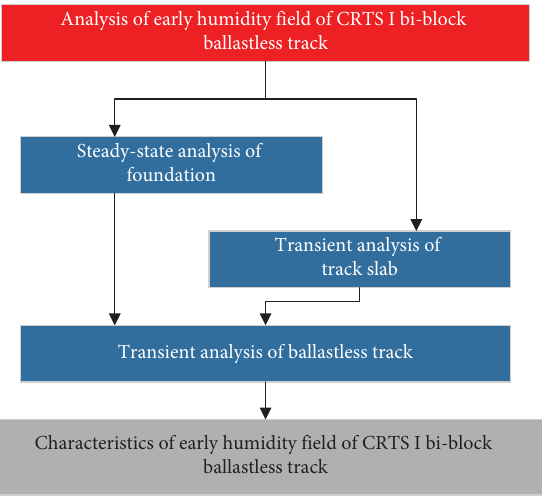
Figure 9: Early humidity field calculation process of CRTS I bi-block ballastless track.